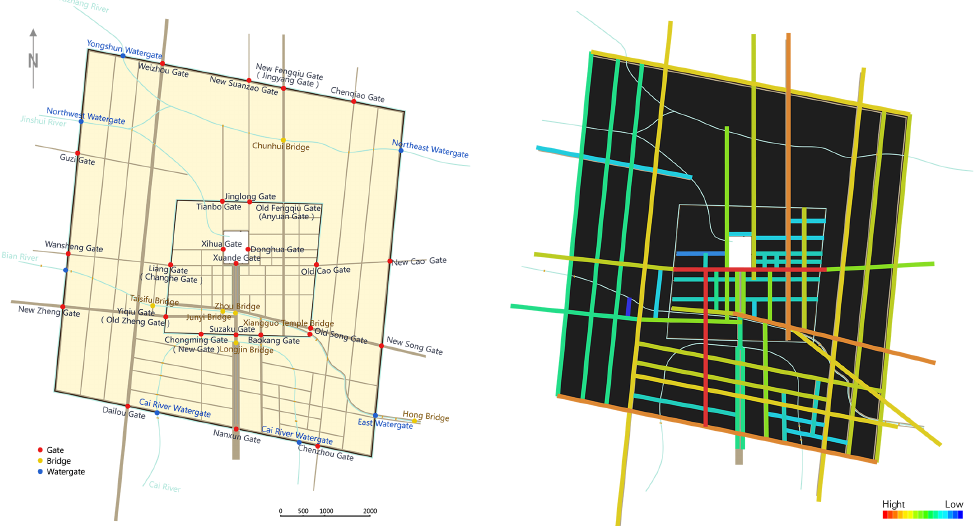
Figure 9. The local integration value of Dongjing of the Northern Song